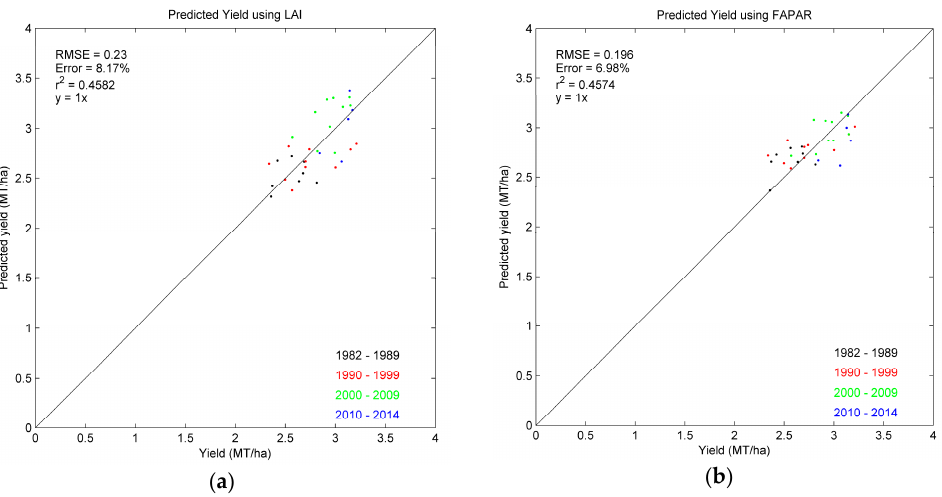
Figure 11. National winter wheat predicted yield in the U.S. applying [1] method to LAI ( a ) and FAPAR ( b ) AVHRR data.